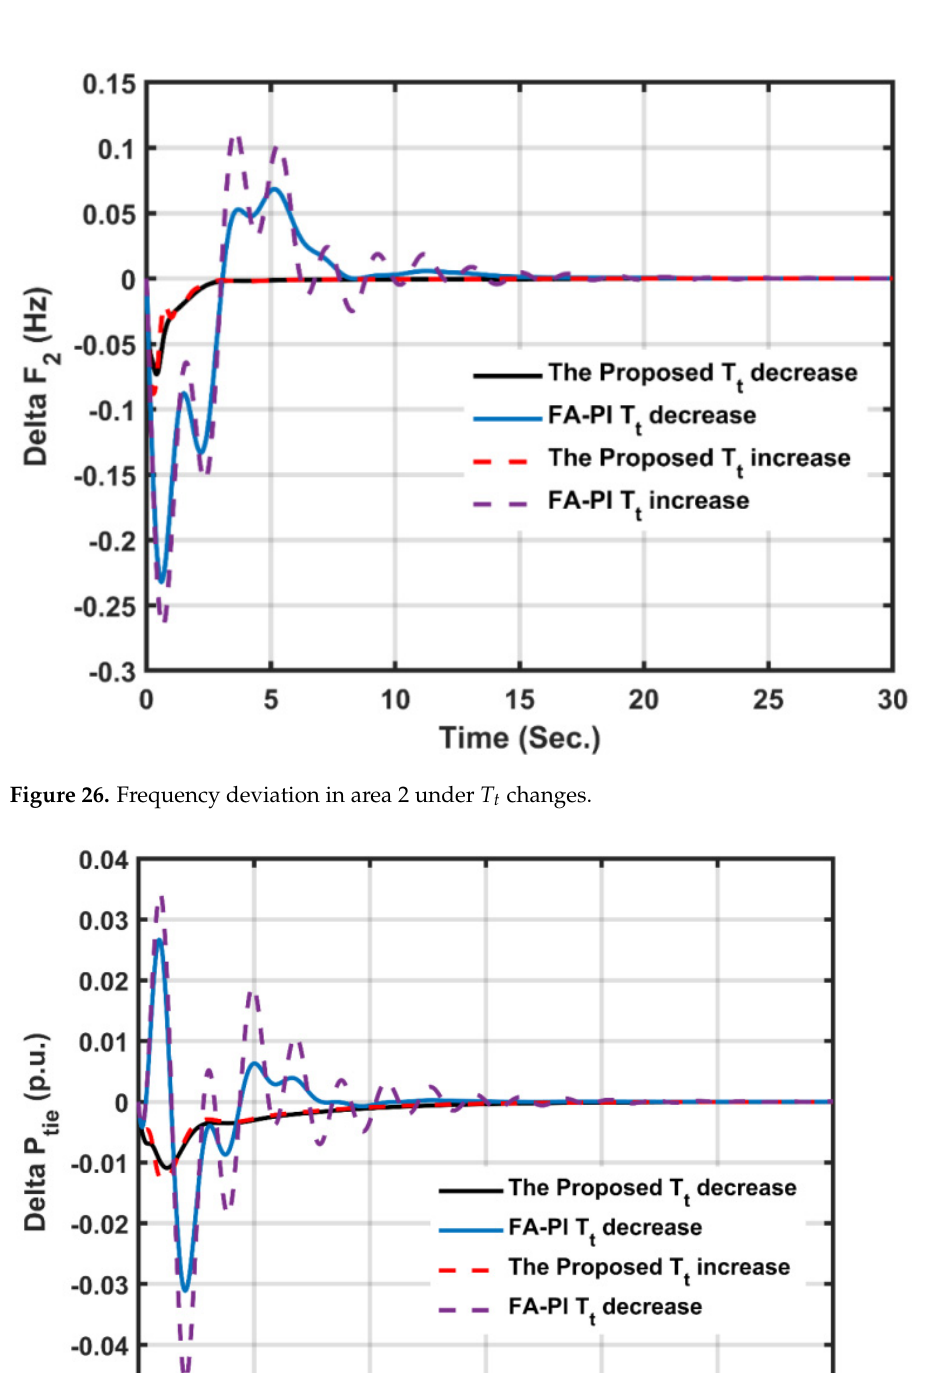
Figure 25. Frequency deviation in area 1 under T t changes.